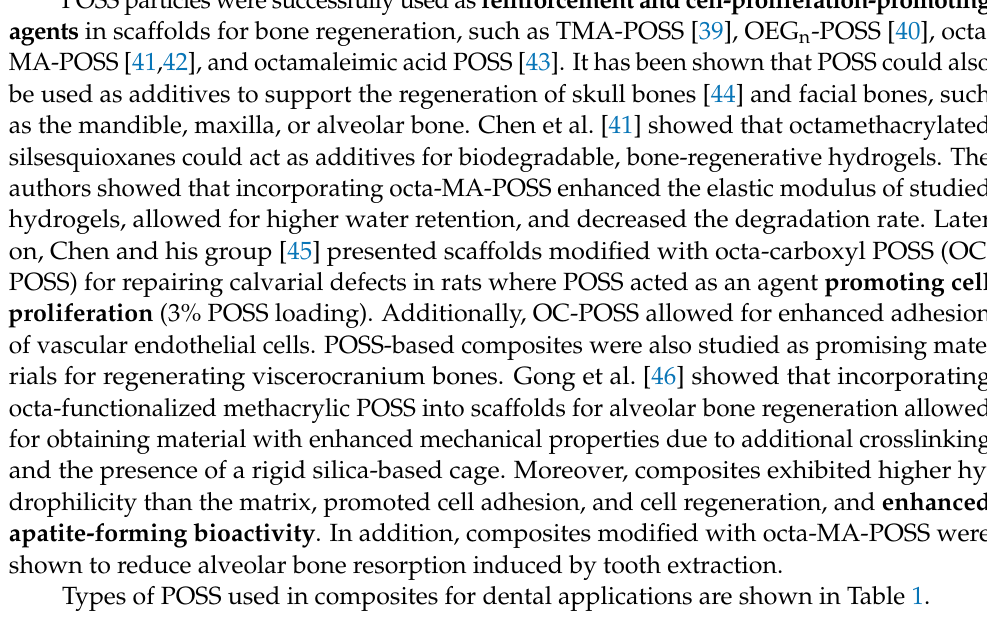
Table 1. POSS in dental